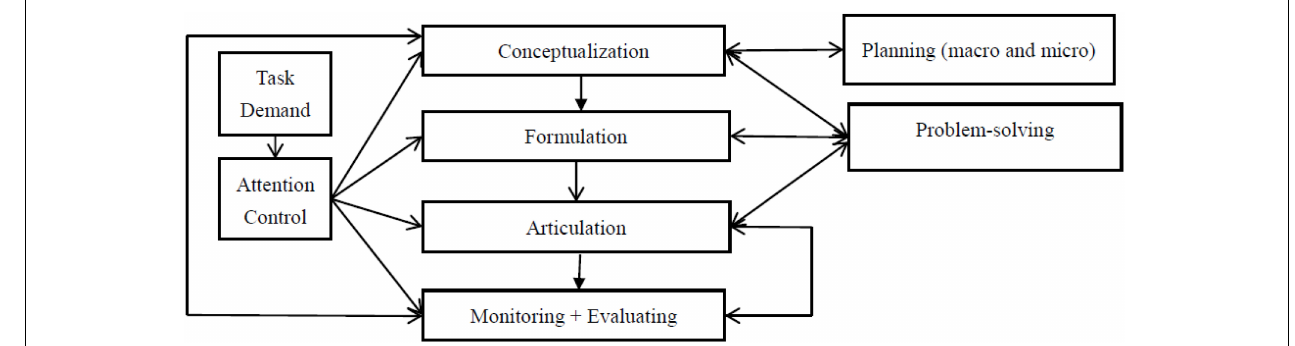
FIGURE 1 | Working mode of metacognitive strategies in Kormos’